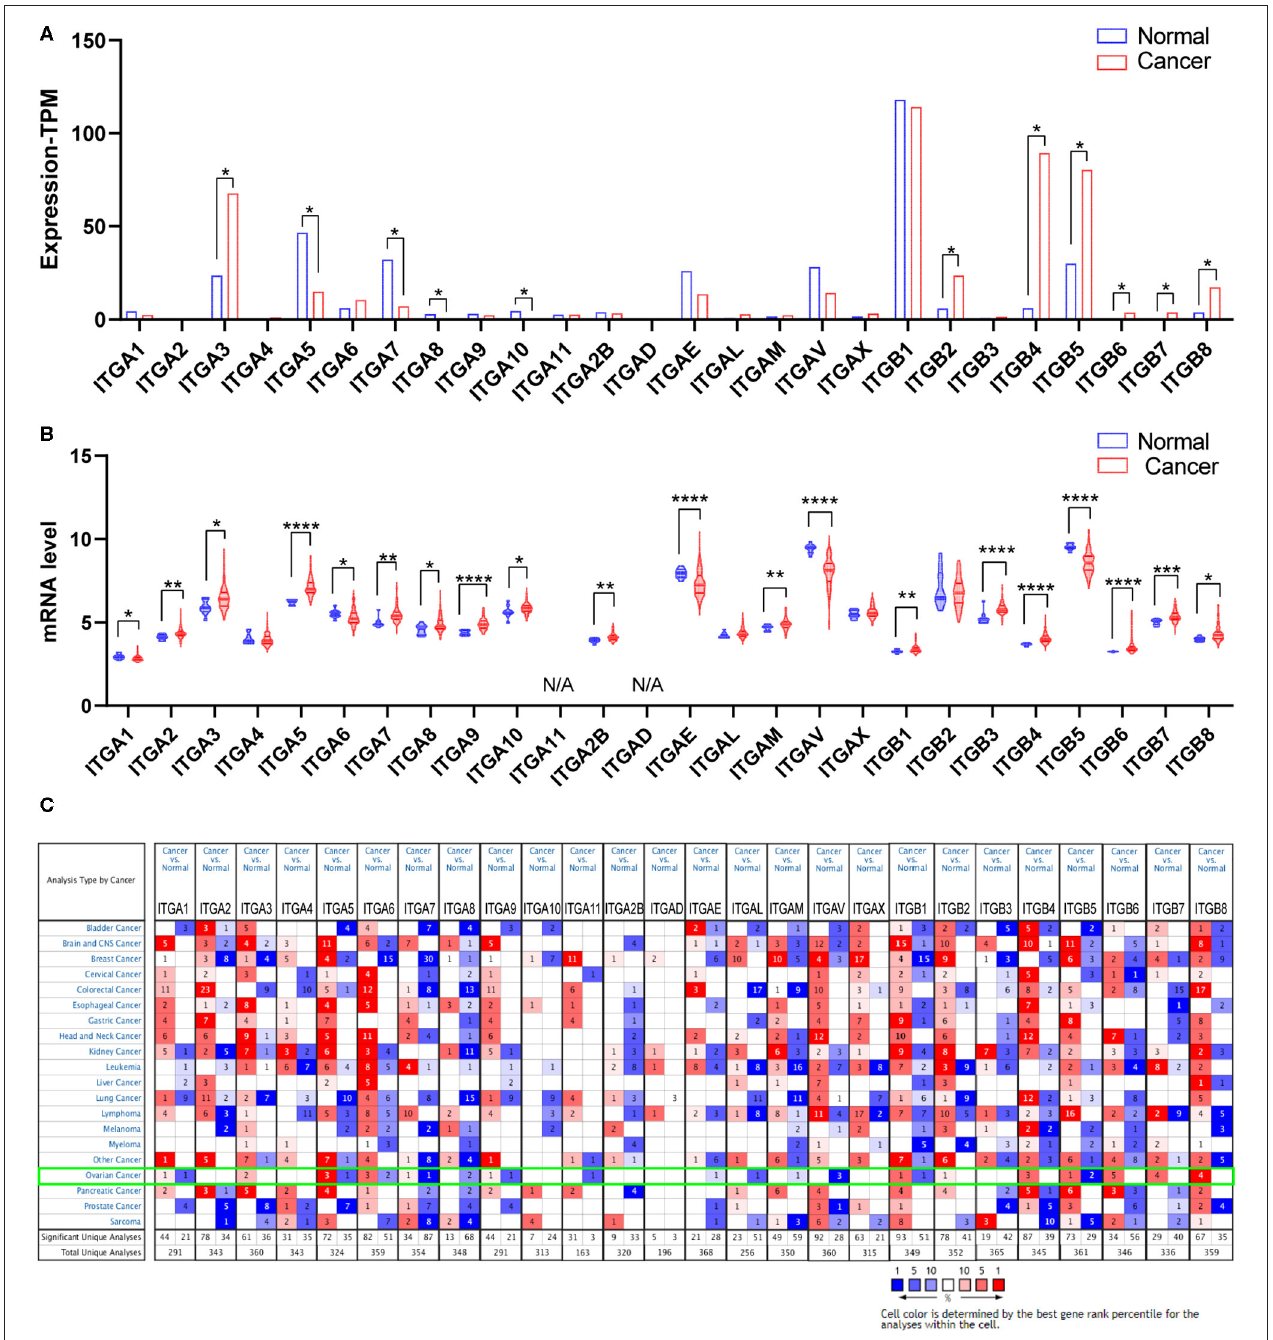
FIGURE 1 | Expression of integrin members in normal ovary and ovarian cancer tissue. (A) The transcriptional expression from GEPIA database, * p < 0.05, number (cancer) = 426, number (normal) = 88. (B) The transcriptional expression from GEO database GSE26712, * p < 0.05, ** p < 0.01, *** p < 0.001, **** p < 0.0001. number (cancer) = 185, number (normal) = 10. (C) The transcriptional expression from ONCOMINE database, threshold setting was p -value: 0.01, fold change: 1.5, gene rank: all, data type: mRNA.